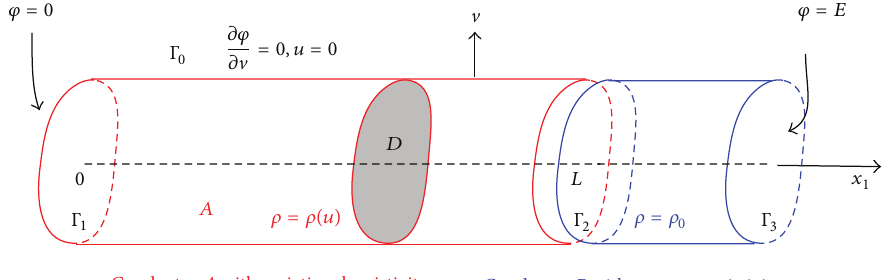
Figure 1: Electric current flows through two